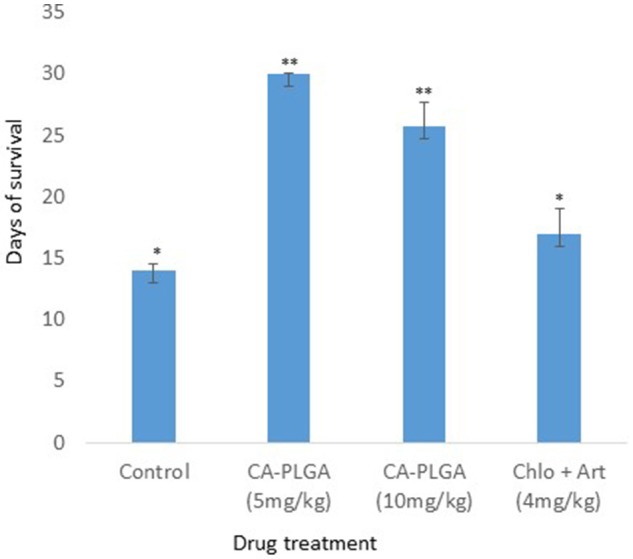
Survival of mice after drug administration. ** was significantly higher than *.